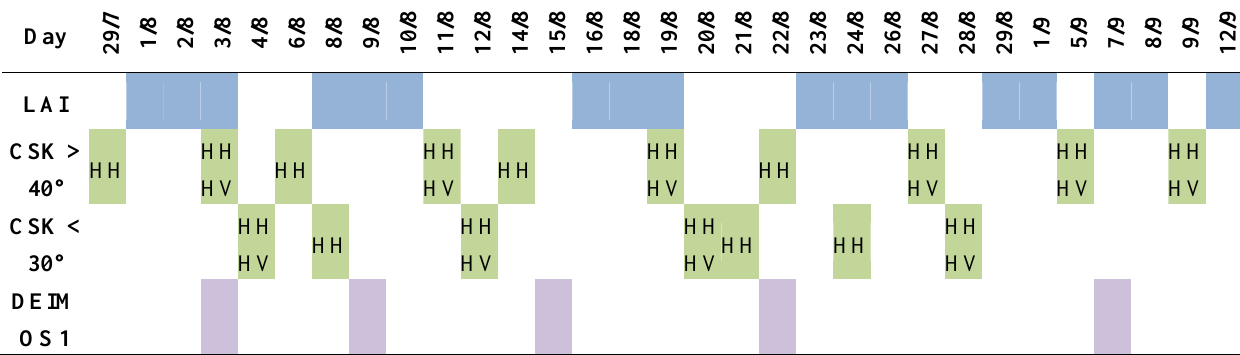
1. Acquisition time of in situ leaf area index (LAI), DEIMOS-1 and COSMO-SkyMed (CSK) images (SP in single polarization and PP in dual polarization).